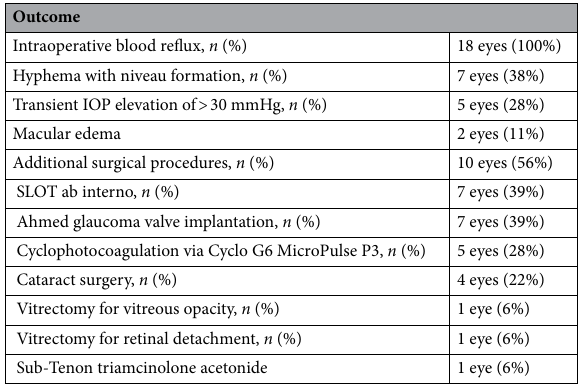
Table 3. Intraoperative and Postoperative Complications. IOP intraocular pressure, SLOT suture